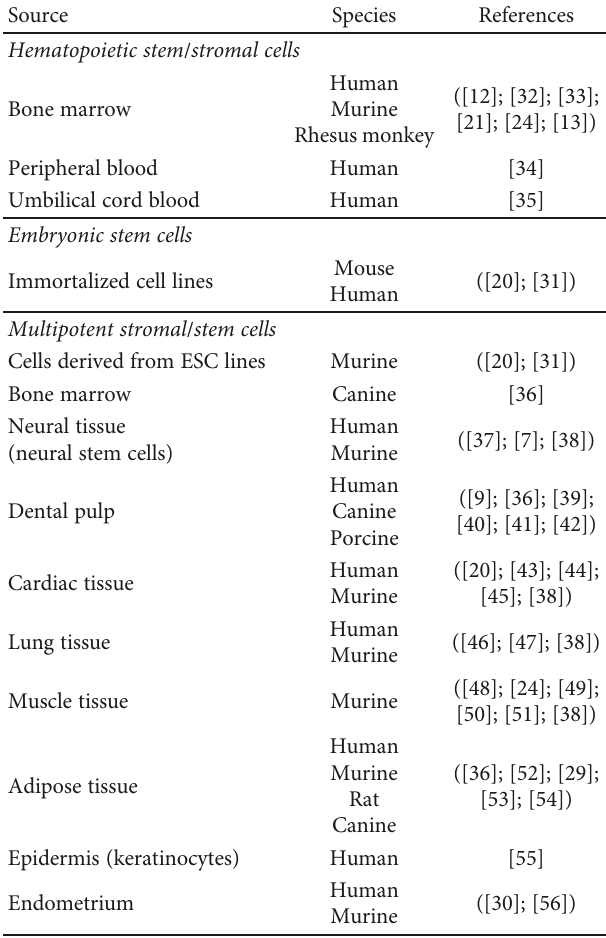
Table 1: List of tissues in which the SP has been identi fi ed. Source